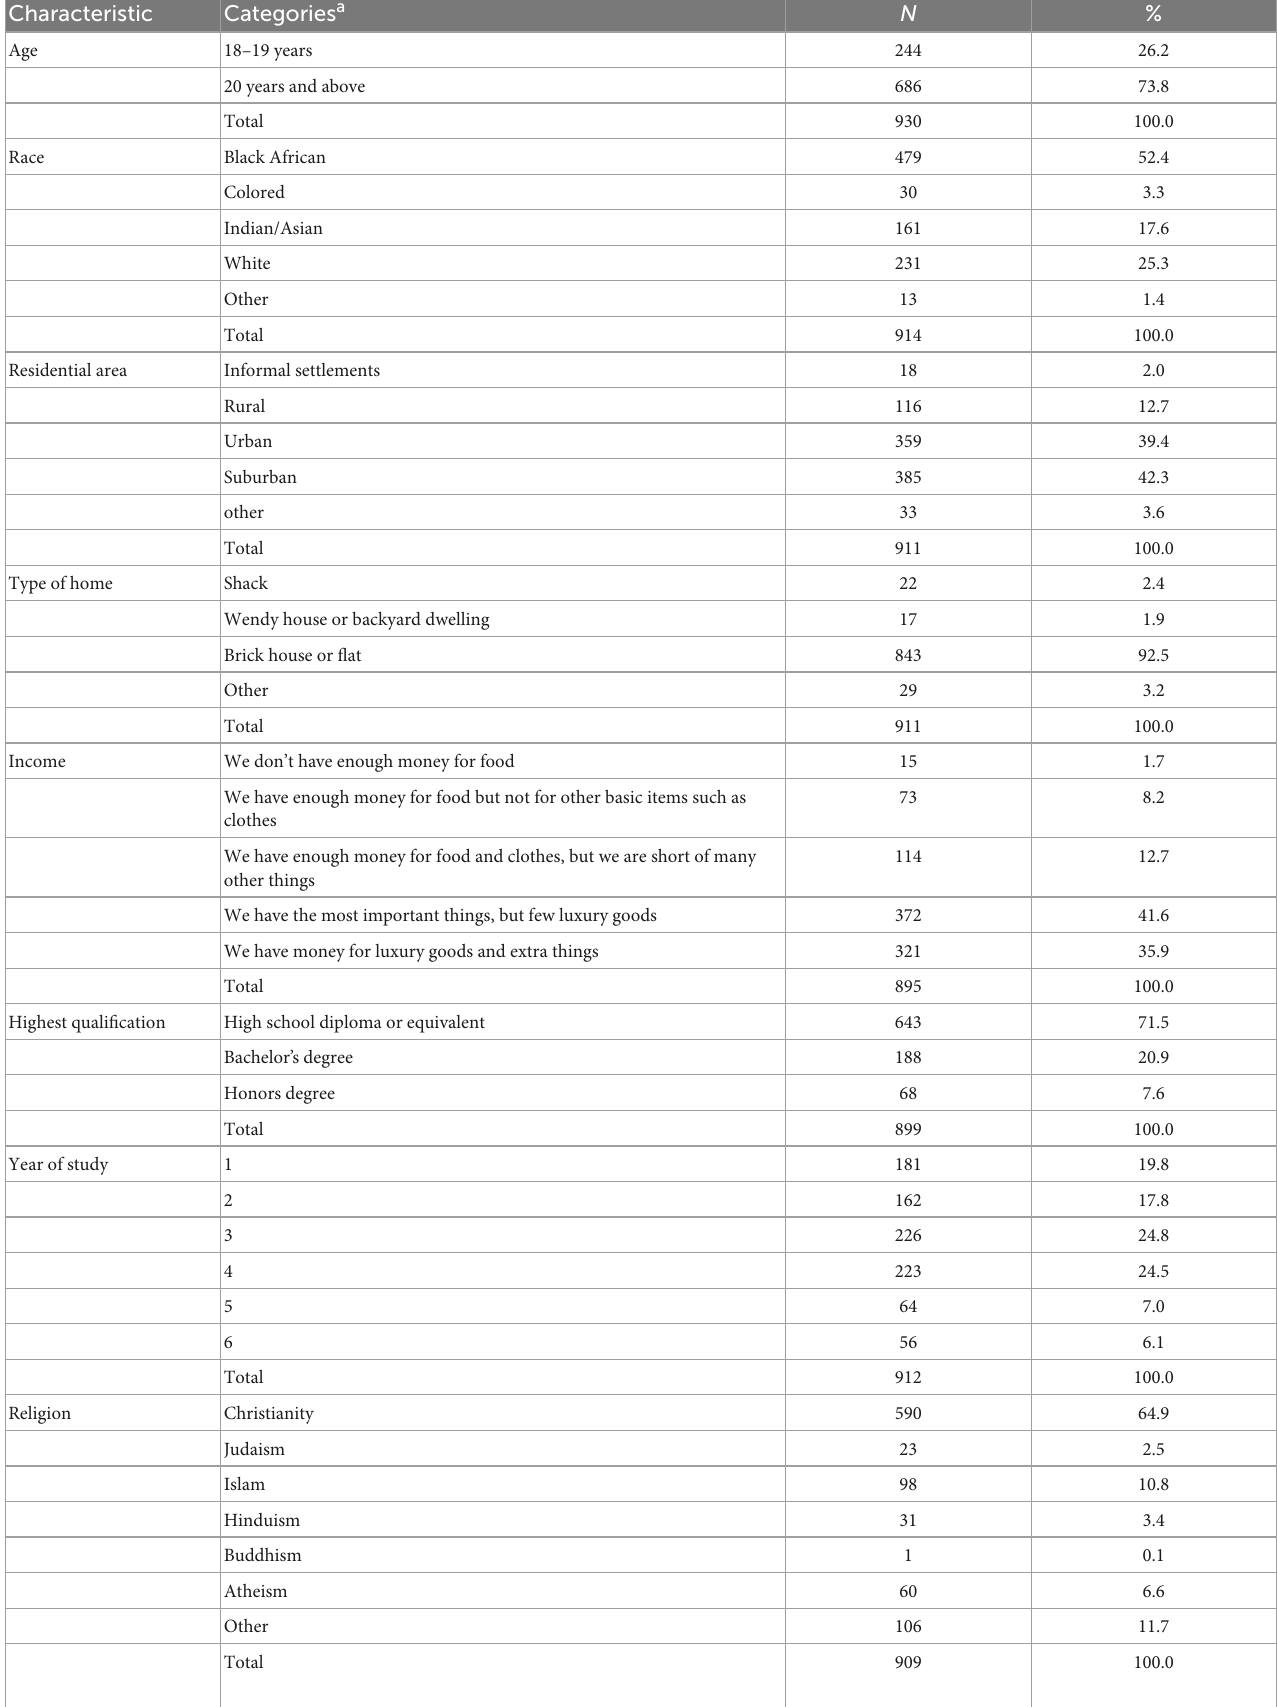
TABLE 1 General characteristics of the University of Witwatersrand undergraduate students ( N = 930) who participated in the survey February–May 2021.